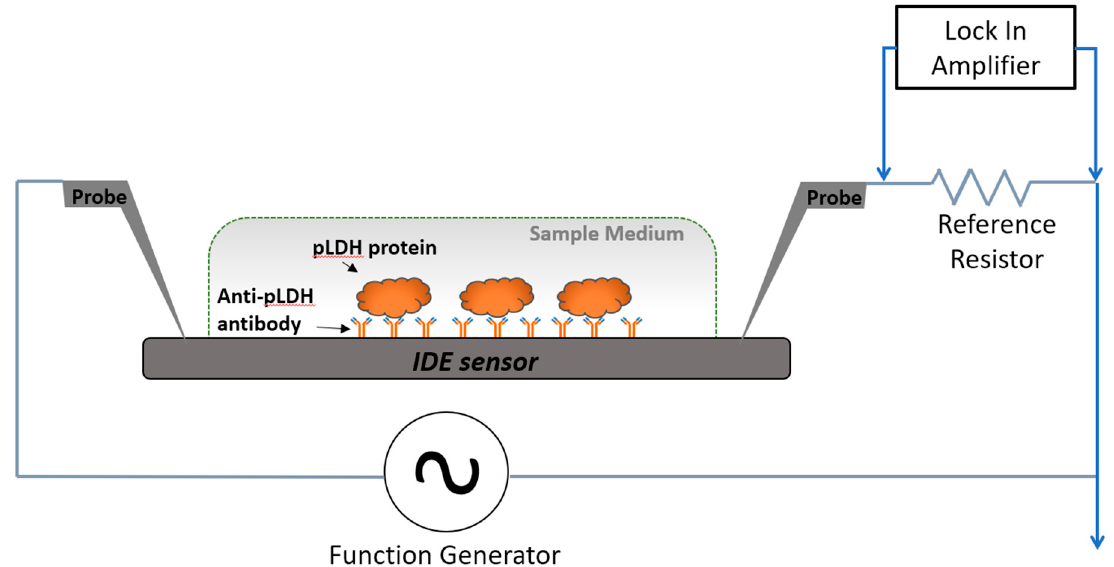
Figure 1. Circuit model and measurement setup used for detection of Plasmodium lactate dehydrogenase (pLDH). The cross-sectional view of the measurement setup illustrates detection of spiked pLDH protein in a sample medium with the sensing area. Probe electrodes were placed to deliver excitation current to, and to measure electrical signals from, the sensors.